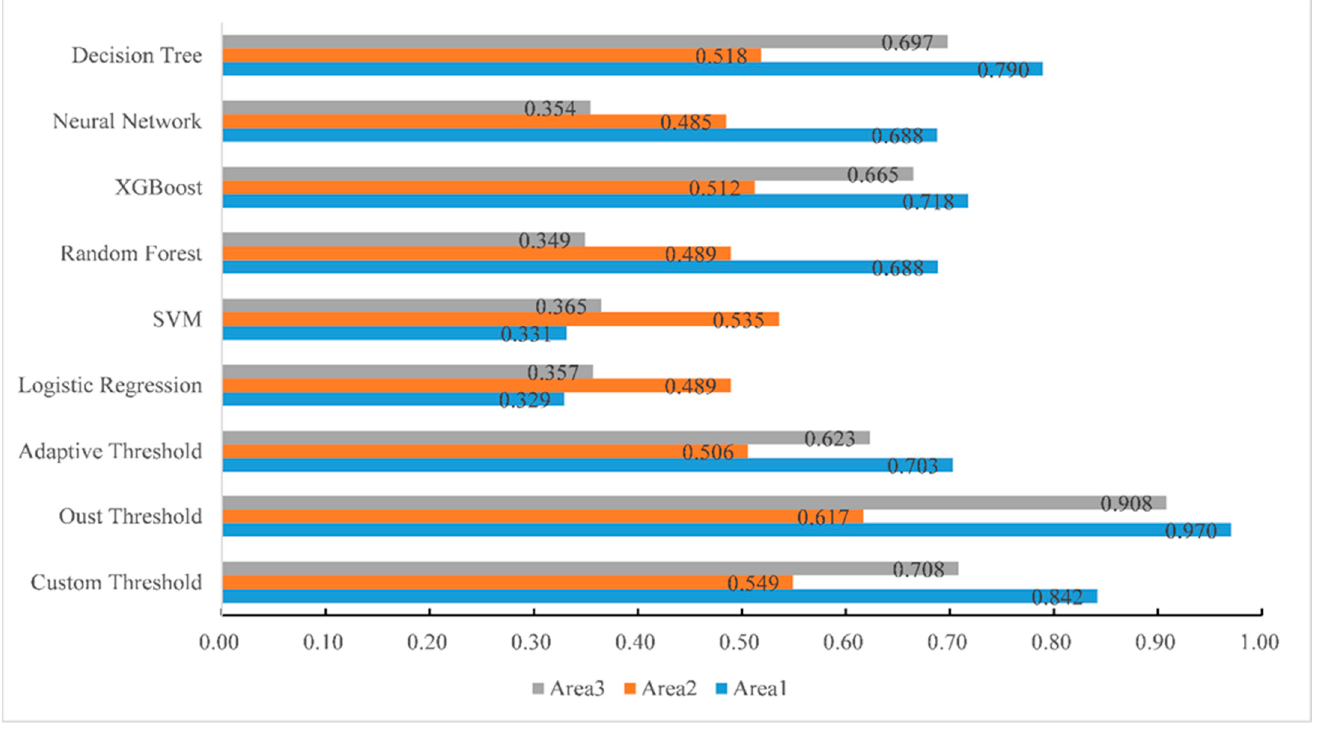
Figure 4. The AUC indexes of the three regions in different periods for each algorithm. However, the water extraction effect of the threshold method is related to the remote sensing image data, and the water extraction effects of remote sensing images from different periods do not affect each other.